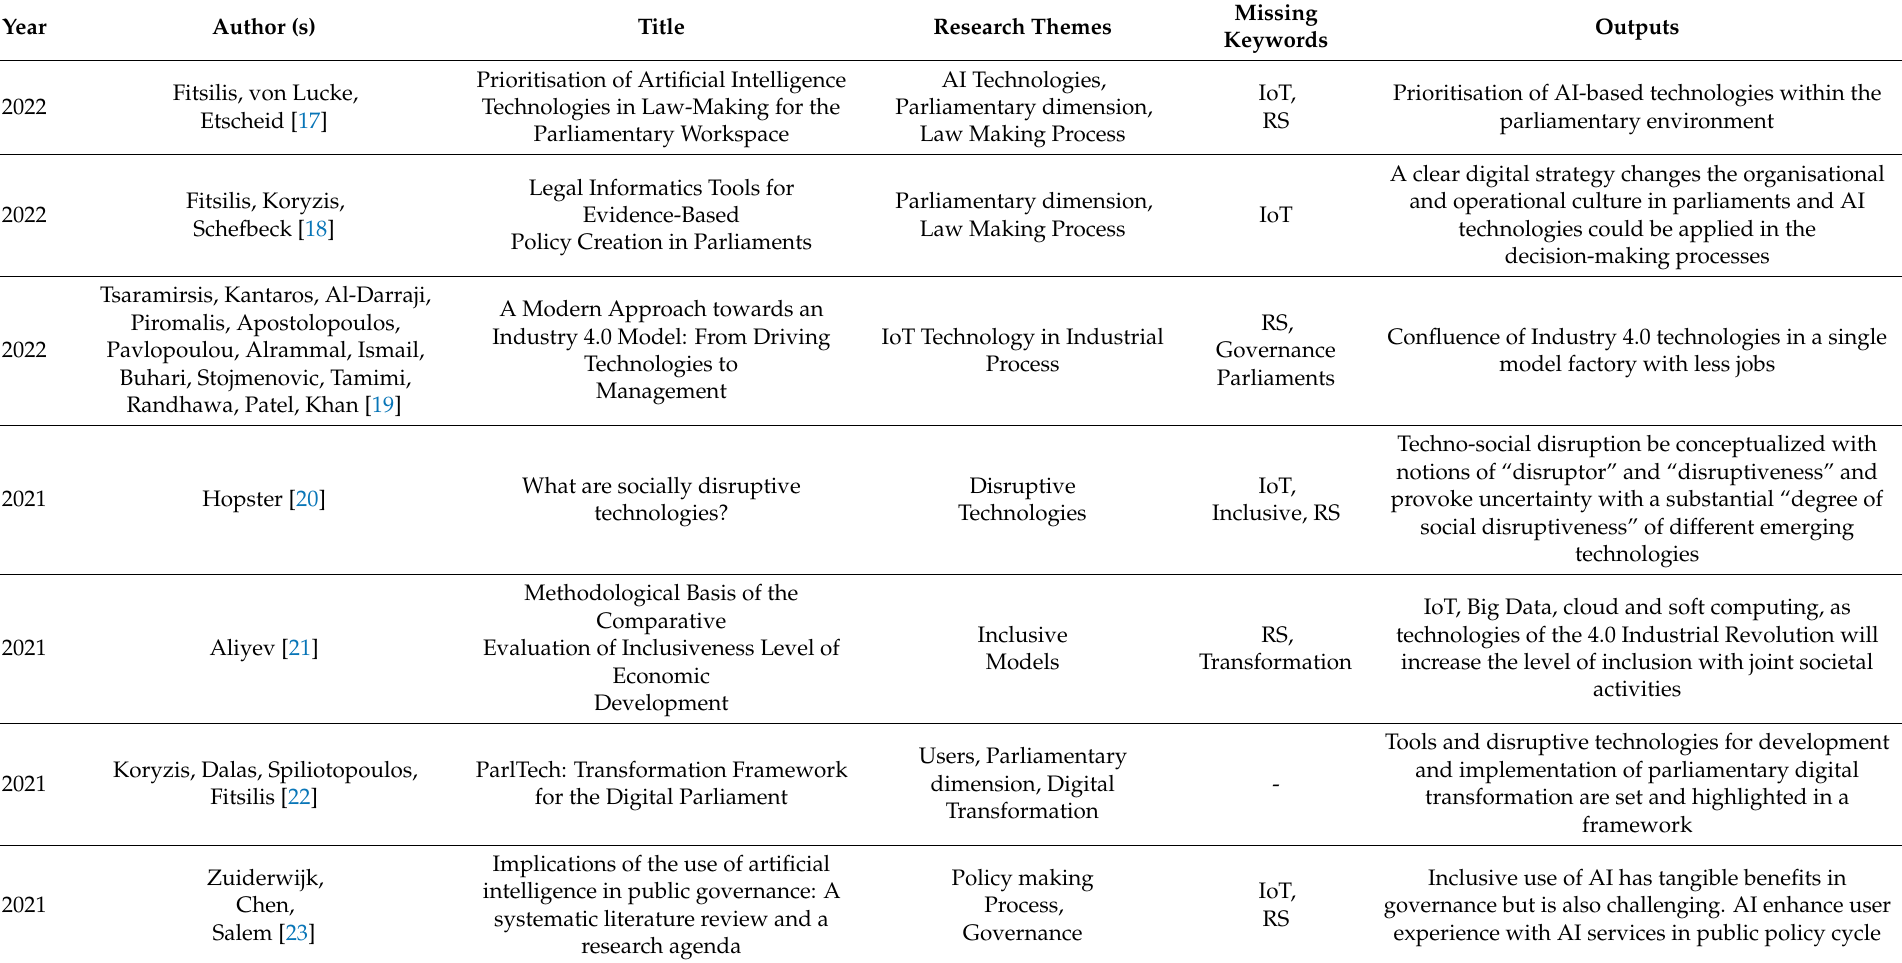
Table 4. Holistic Research Papers for Research Themes and Scientific